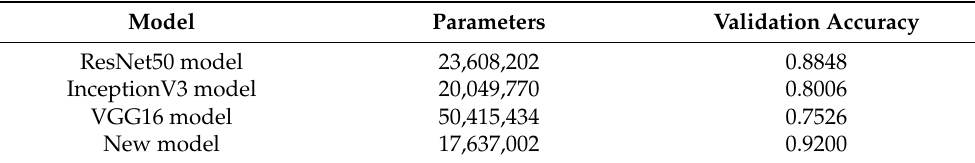
Table 4. Validation accuracy and the number of parameters of CIFAR-10 images dataset performed with four different classification models.